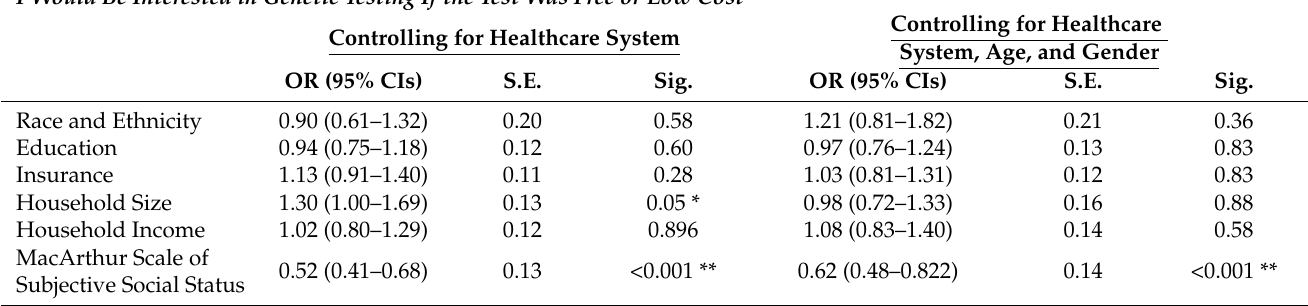
Table 5. Multiple logistic regression of interest outcome 2 controlling for healthcare system, age, and